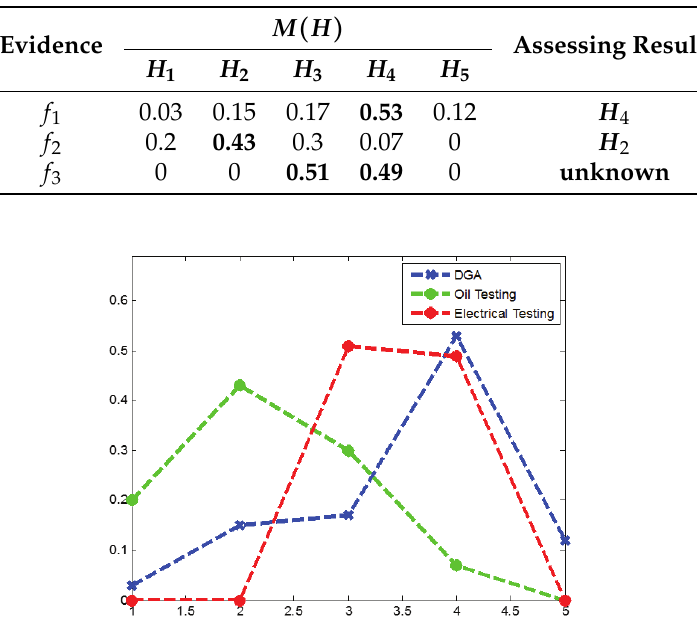
Figure 7. Evaluation grades of three